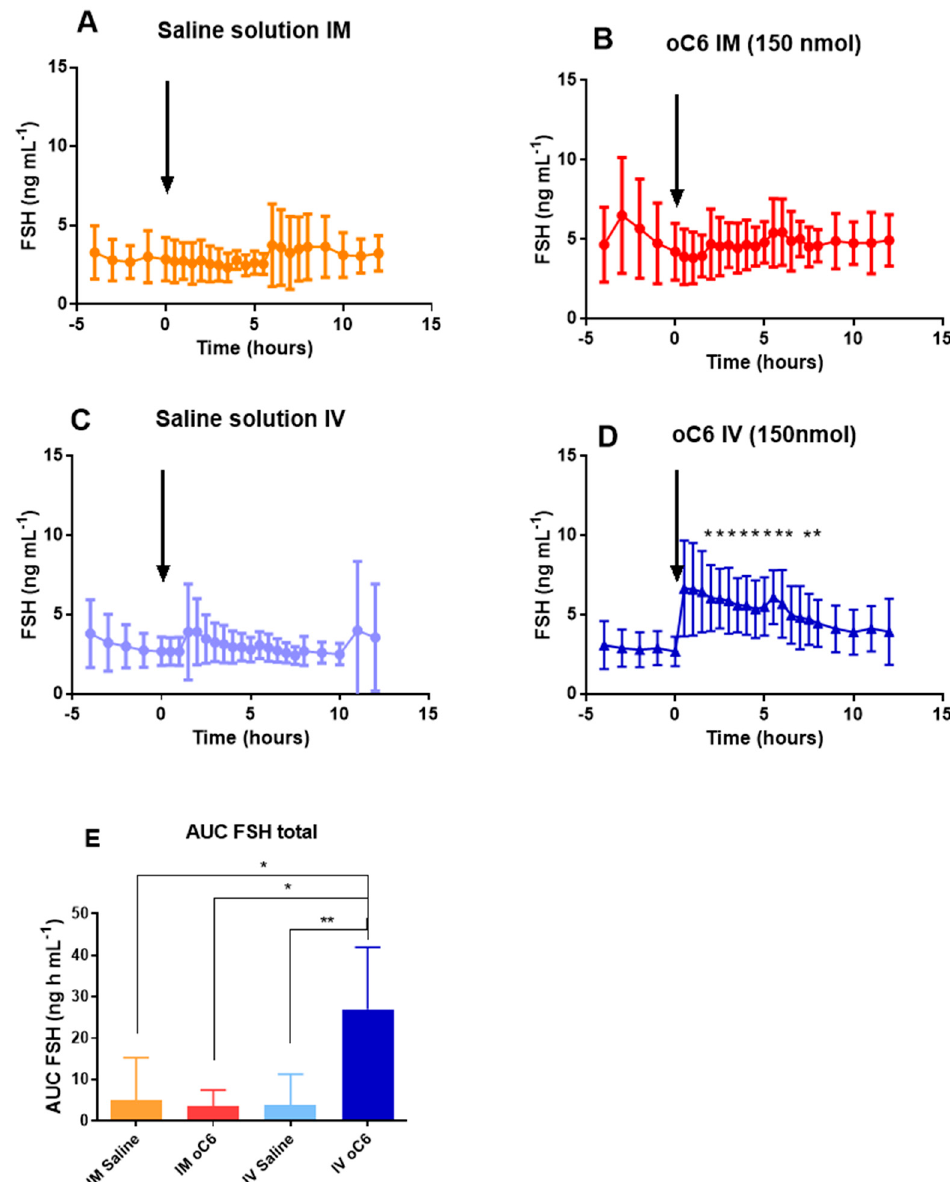
Figure 5. Comparison of the effect of iv and im injection of oC6 on FSH plasma level. During the non-breeding season either oC6 (150 nmol/mare) or saline solution were injected at time zero (arrow) either iv or im. Serial blood samples were taken from 4 h before to 12 h after injection and assessed for FSH content by ELISA. The im injection of oC6 had no effect on FSH plasma level ( B ); F = 1.44, p = 0.1), conversely the iv injection of oC6 significantly increased FSH plasma concentration ( D ); F = 8.84, p < 0.001; stars on individual point indicate a significant difference from pre-treatment values). Injections of saline solution im or iv had no effect on FSH plasma concentration ( A ); F = 0.89, p = 0.61; ( C ); F = 0.78, p = 0.76 respectively). The analysis of the area under the curve (AUC) showed that the total amount of FSH released after an iv injection of oC6 is larger than after an im injection (( E ); X 2 = 11.85, p = 0.008; * p ≤ 0.05, ** p ≤ 0.01). Data are expressed as mean ± SD. Statistical analysis was performed using ANOVA on repeated measures ( A – D ) Kruskal Wallis followed by Dunn’s post hoc test ( E ).